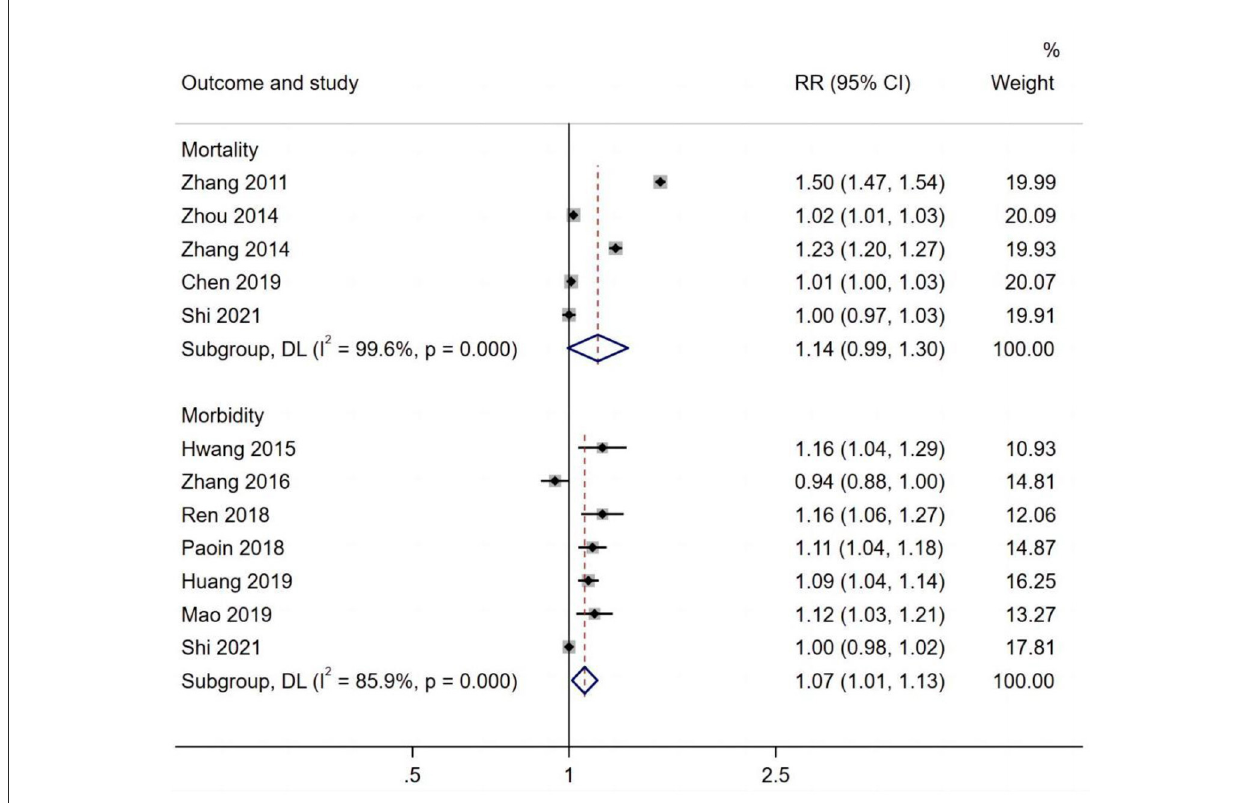
FIGURE4 PM 10 effects on cardiovascular disease mortality and